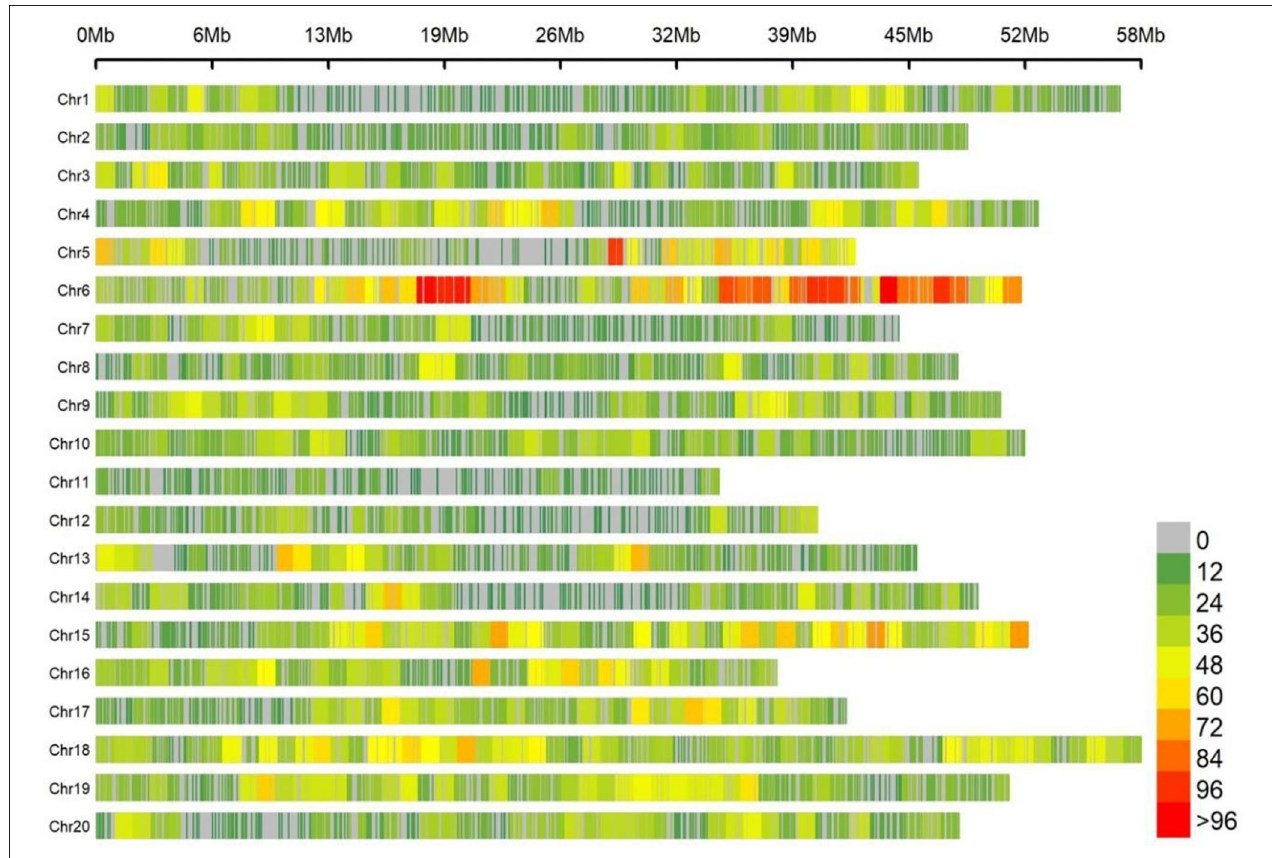
FIGURE 2 | Single-nucleotide polymorphism (SNP) density and distribution across 20 soybean chromosomes.